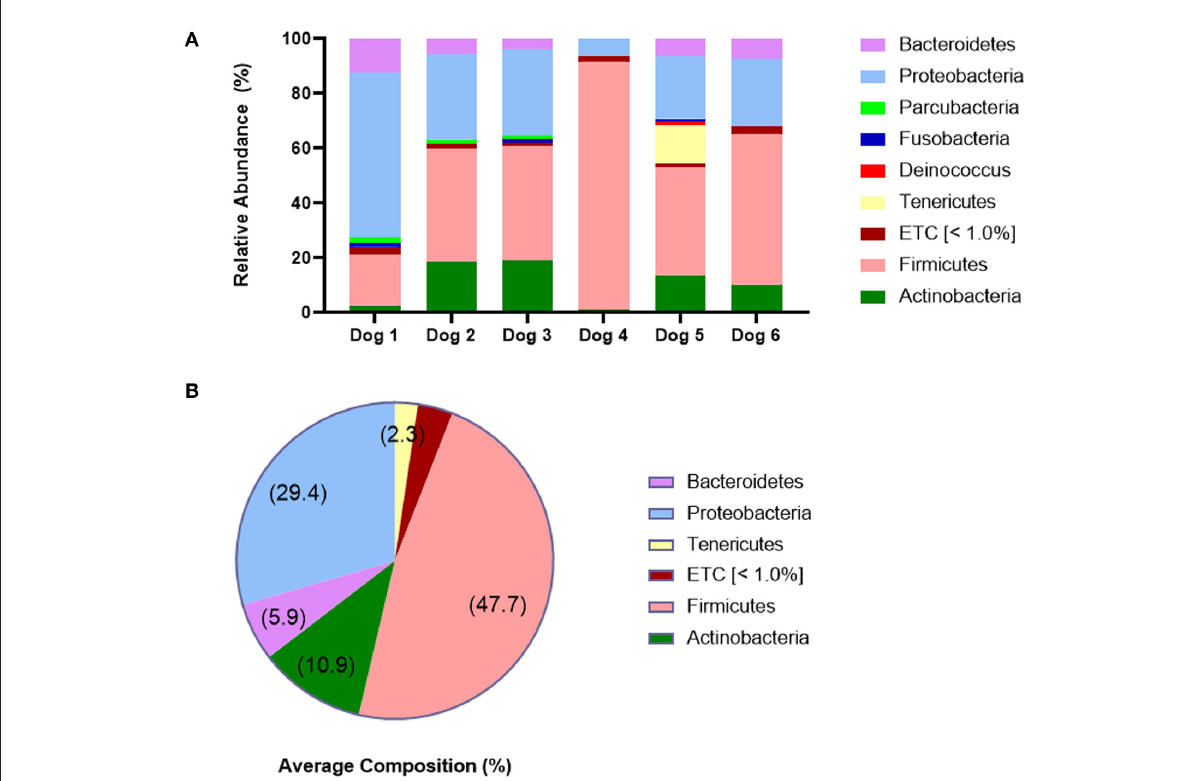
FIGURE8 Skin microbiome analysis at the phylum level. (A) Individual composition of bacterial phyla and (B) average composition of bacterial phyla in six dogs at post-provocation. The most abundant phylum was Firmicutes, followed by Proteobacteria and Actinobacteria, which shows bacterial dysbiosis. The cut-off value for ETC taxa is 1.0%.